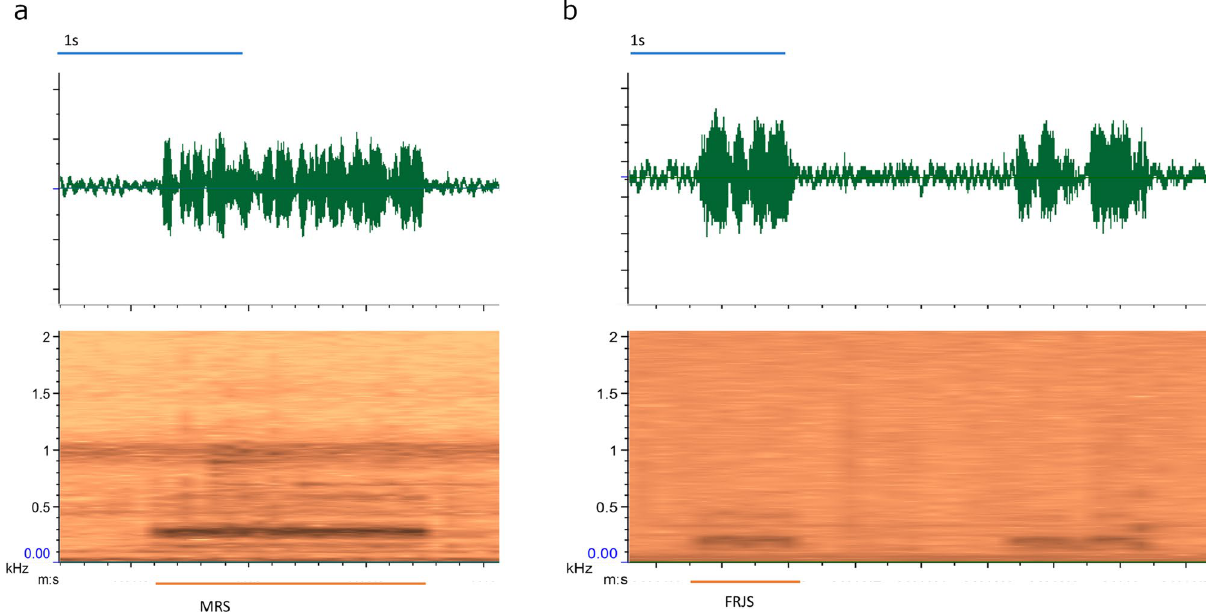
Figure 3. Oscillogram (above) and spectrogram (below) of GW vibrational signals. In ( a ) MRS, ( b )